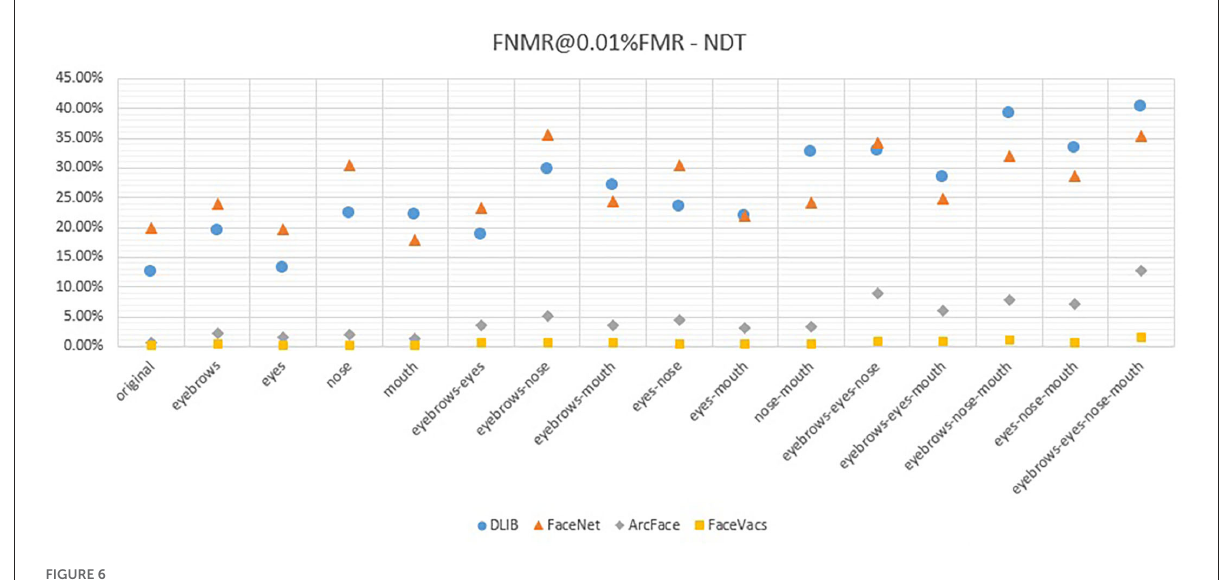
FIGURE6 The behavior of deep FRs on NDT experiment.